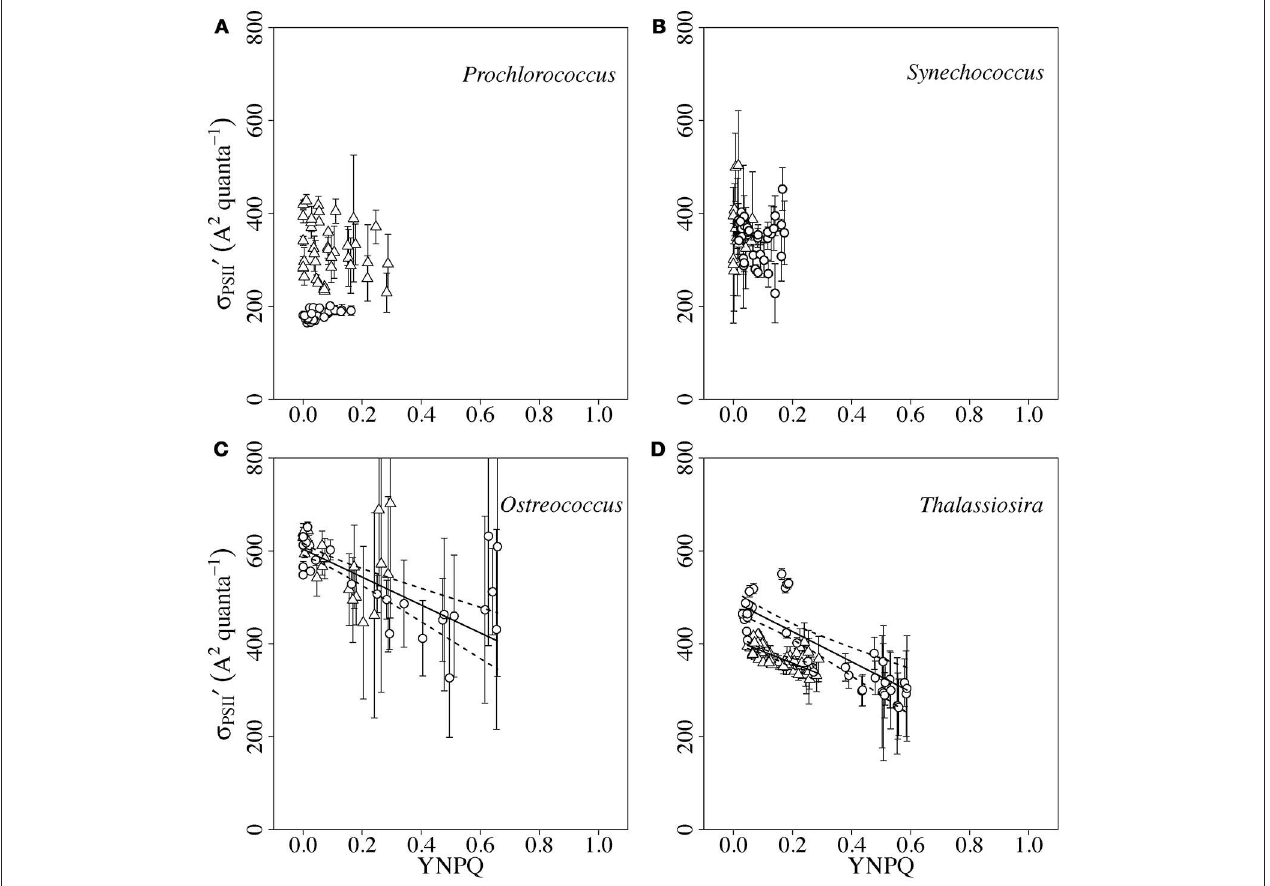
FIGURE 4 | σ PSII ′ vs. YNPQ in Prochlorococcus (A) , Synechococcus (B) , Ostreococcus (C) or Thalassiosira (D) from growth-limiting (open triangles) or growth saturating light (open circles). Induction of YNPQ was driven by increasing actinic light ( Figure 1A ). Paired determinations from 4 to 8 replicate cultures plotted individually. Solid lines show linear regressions; dotted lines show 95% C.I. on the regression